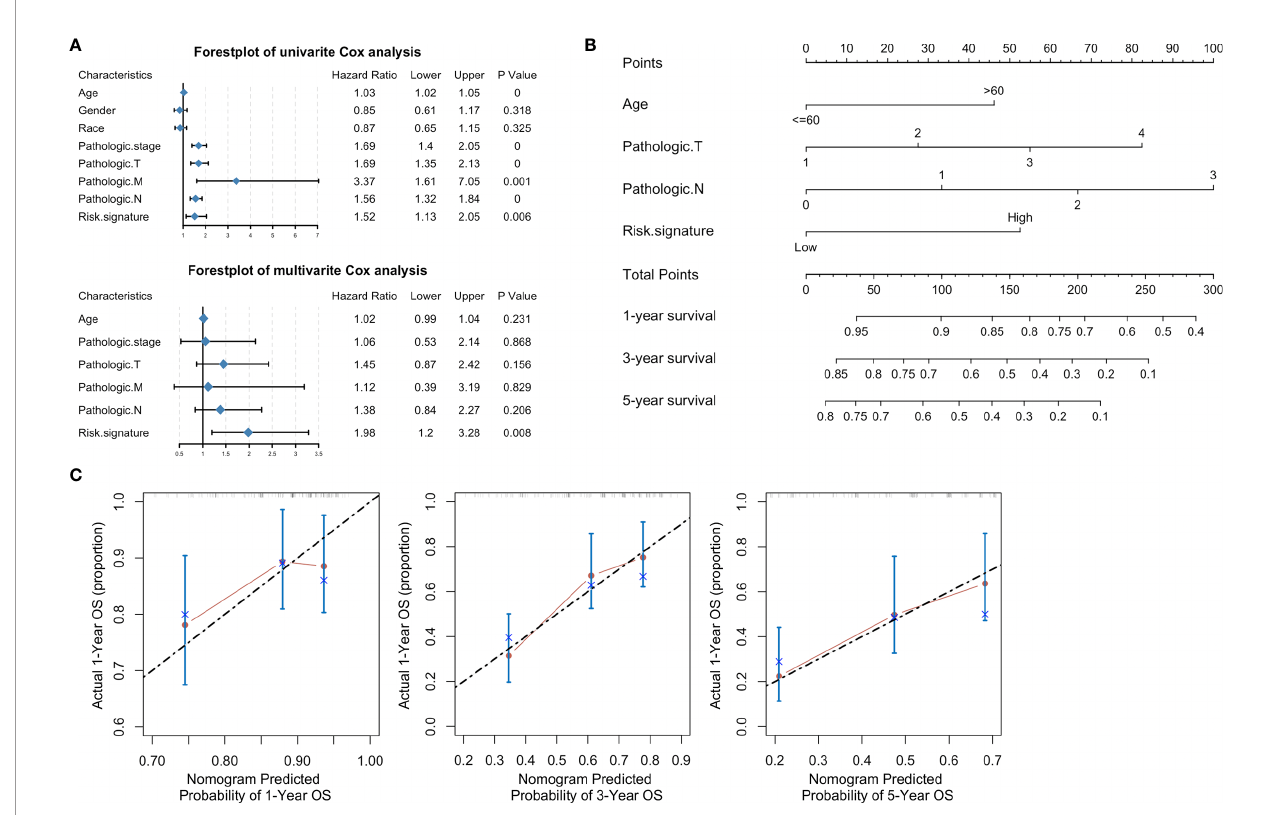
FIGURE 9 | A nomogram based on clinical characteristics. (A) Forest plot of clinical characteristics after univariate and multivariate Cox analyses. (B) Nomogram of prediction for 1-, 3-, 5-year survivals. (C) Calibration curves of the nomogram-predicted 1-, 3-, 5-year